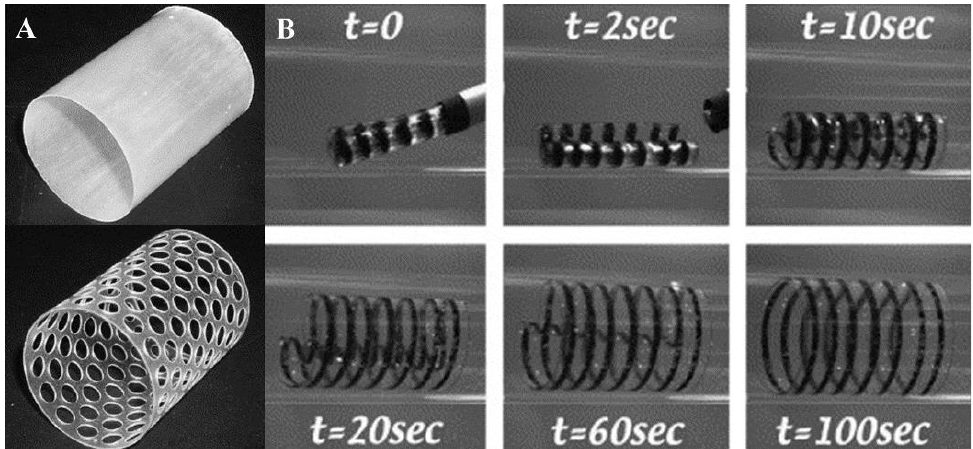
Figure 4. Photo sequence of shape memory polymer stent and its recovery. Solid and 50% perforated stents ( A ). The stent packaged in an 18 Fr. Catheter expands to 22 mm in a 37 ° C water bath ( B ). Reprinted with permission from [73].